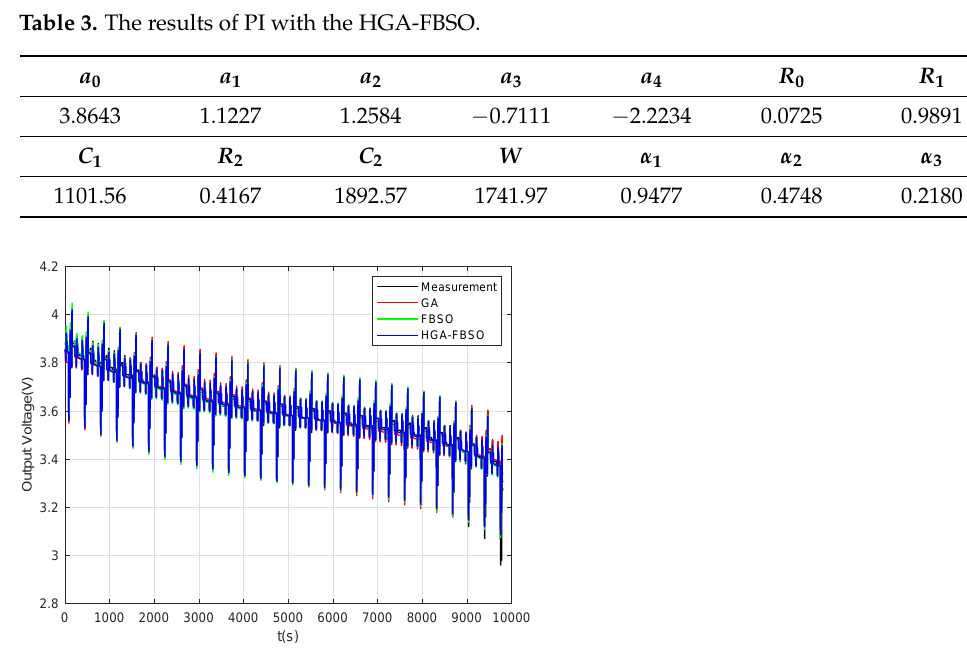
Figure 3. Accuracy of the GA, FBSO and